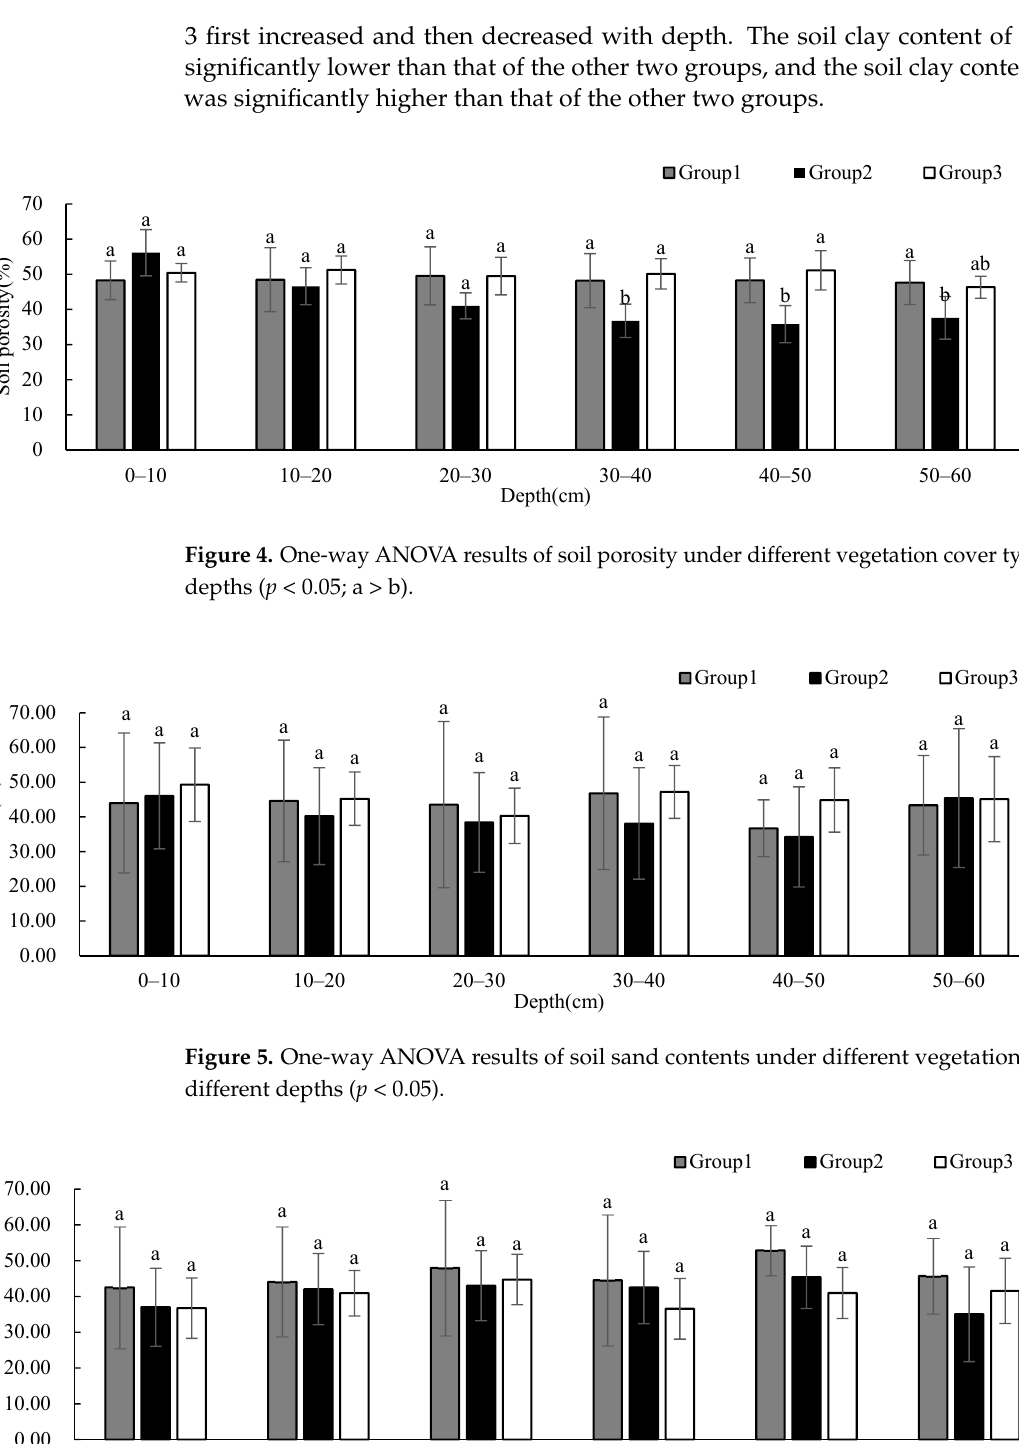
Figure 5. One-way ANOVA results of soil sand contents under different vegetation cover types at different depths ( p < 0.05). Figure 6. One-way ANOVA results of soil silt contents under different vegetation cover types at different depths ( p < 0.05).